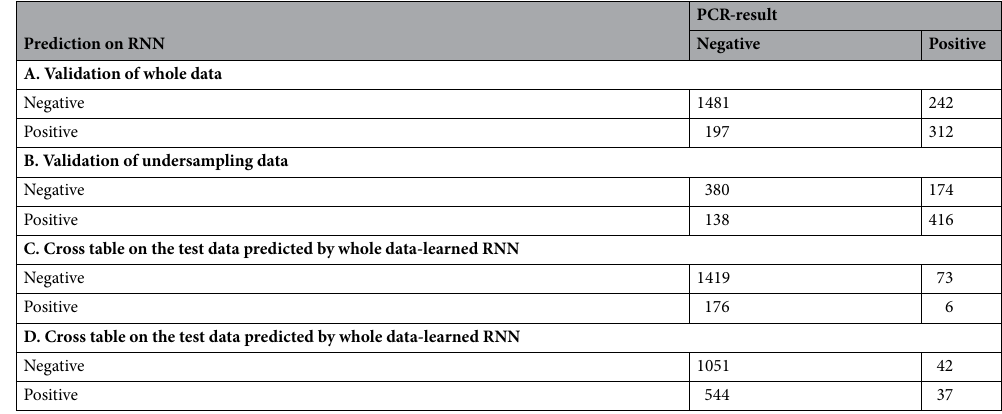
C. Cross table on the test data predicted by whole data-learned RNN